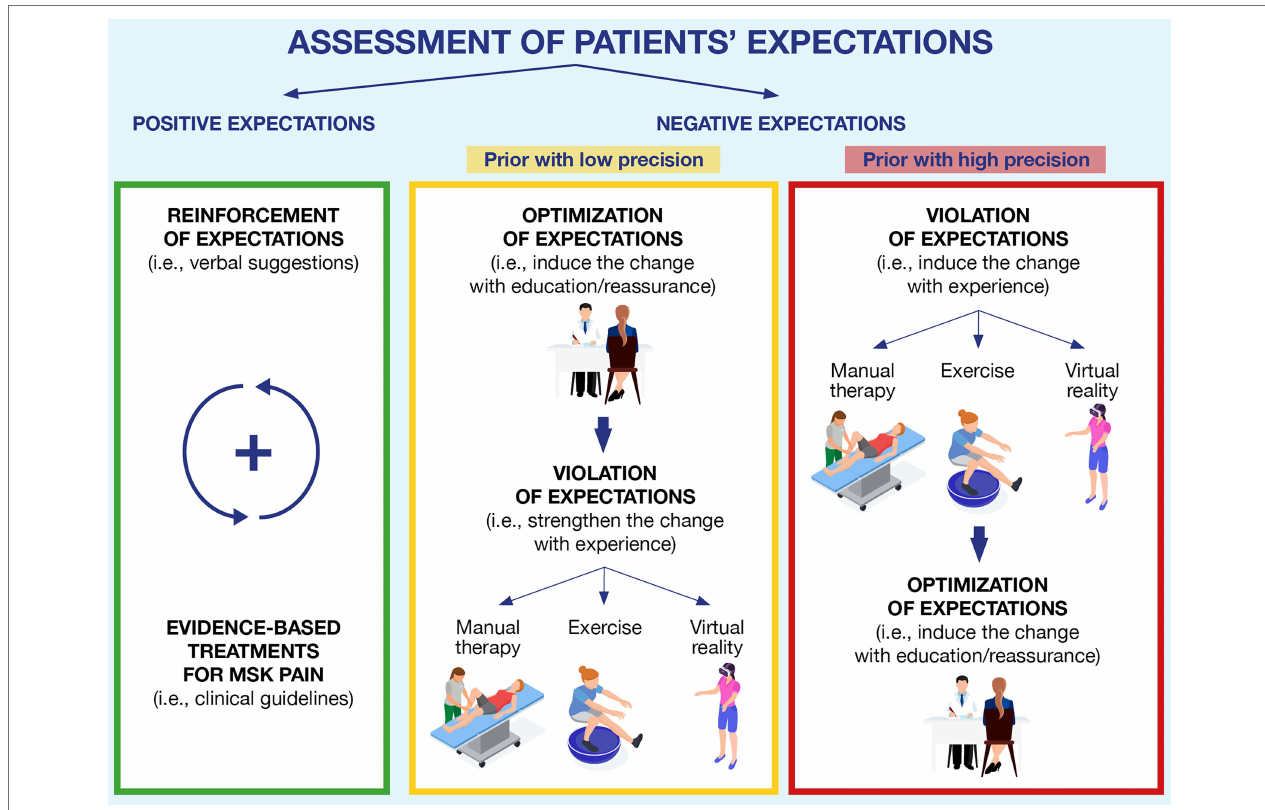
FIGURE 2 | A clinical framework to assess and address patients’ expectations in musculoskeletal pain. The figure depicts the three typical scenarios that can occur in clinical practice. Green block: the patient shows positive expectations toward the rehabilitation process, and the clinician can reinforce them by providing verbal suggestions and confirming such expectations with the recommended evidence-based treatments; Yellow block: if negative expectations are detected during the initial assessment, but they have low precision, the clinician can optimize them through education and reassurance and subsequently try to violate such expectations by exposing patients to experience (using manual therapy, exercise, virtual reality, or a combination of them); and Red block: if high-precision expectations are detected, we suggest starting by exposing patients to experiences that could challenge patients’ expectations, and if this outcome is achieved, it can be reinforced through verbal suggestions (education or